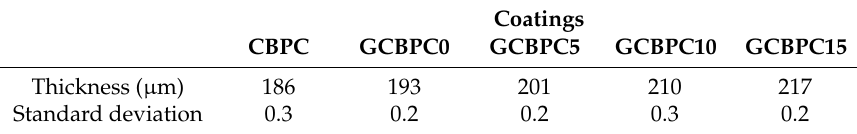
Table 3. Thickness of phosphate ceramic coatings after curing.